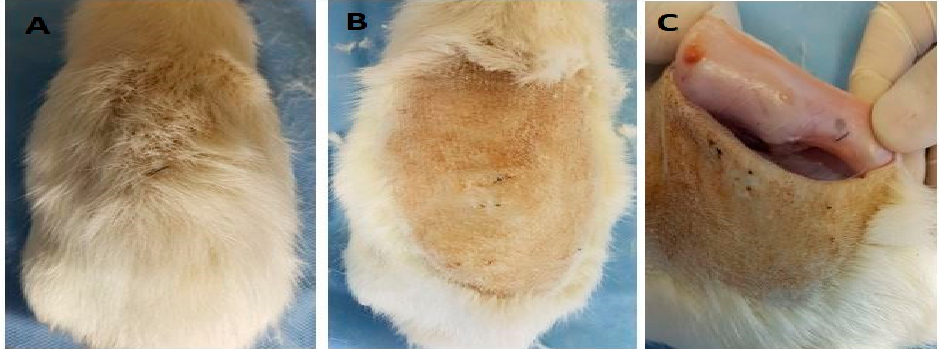
Figure 6. The dorsal area of the rat Wistar after 30 days of the implantation: ( A ) hair recovery, ( B ) absence of injuries and infections, and ( C ) internal surface of the skin where the implanted samples are encapsulated by scar tissue.